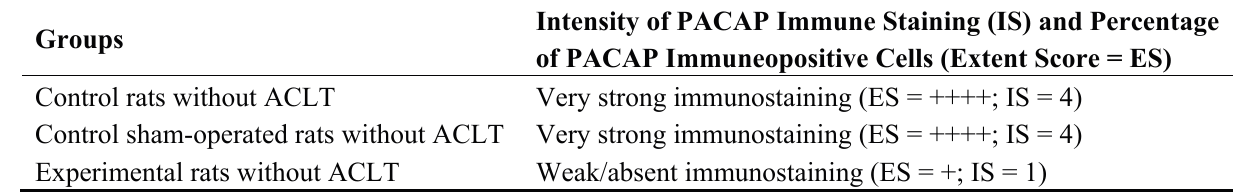
Table 1. Evaluation of PACAP immunostaining. Intensity of staining (IS) was graded on a scale of 0–4, according to the following assessment: no detectable staining (0), weak staining (1), moderate staining (2), strong staining (3), very strong staining (4). The percentage of PACAP immunopositive cells (Extent Score = ES) was independently evaluated by 3 investigators (2 anatomical morphologists and one histologist) and scored as a percentage of the final number of 100 cells in five categories: <5% (0); 5%–30% (+);